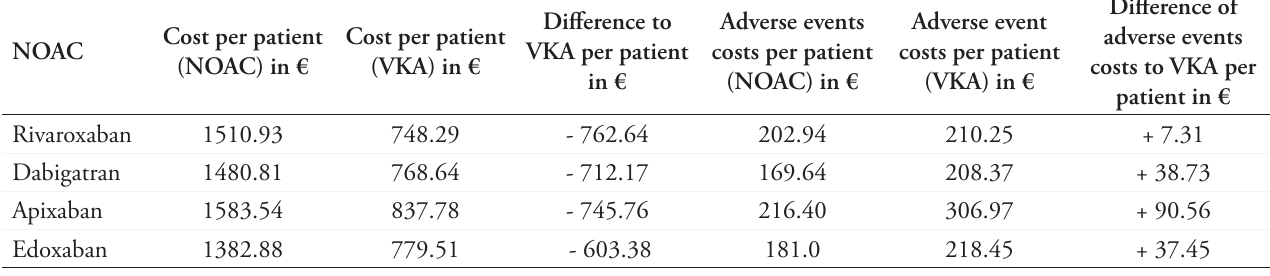
Table 4b: Costs of adverse effects: Results after TTR increase to 78% Cost per NOAC